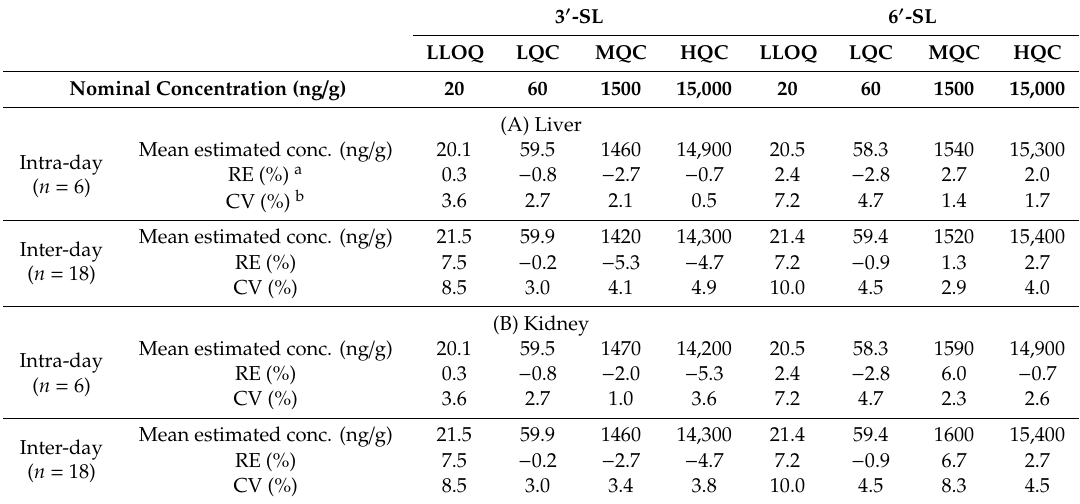
Table 2. Intra- and inter-day accuracy and precision